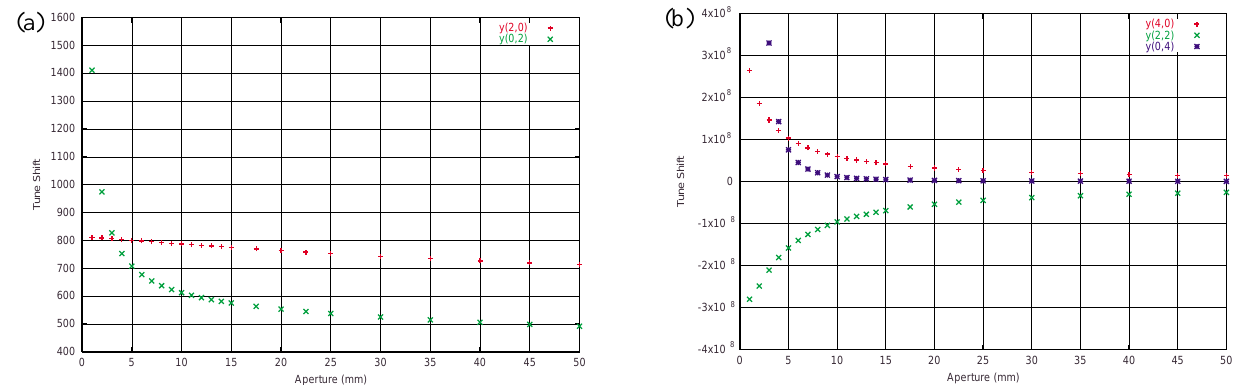
FIG. 8. (Color) (a) Blowup of the second-order and (b) fourth-order amplitude dependent tune shifts in the y tune. The fringe field shape is given by the default Enge coefficients.